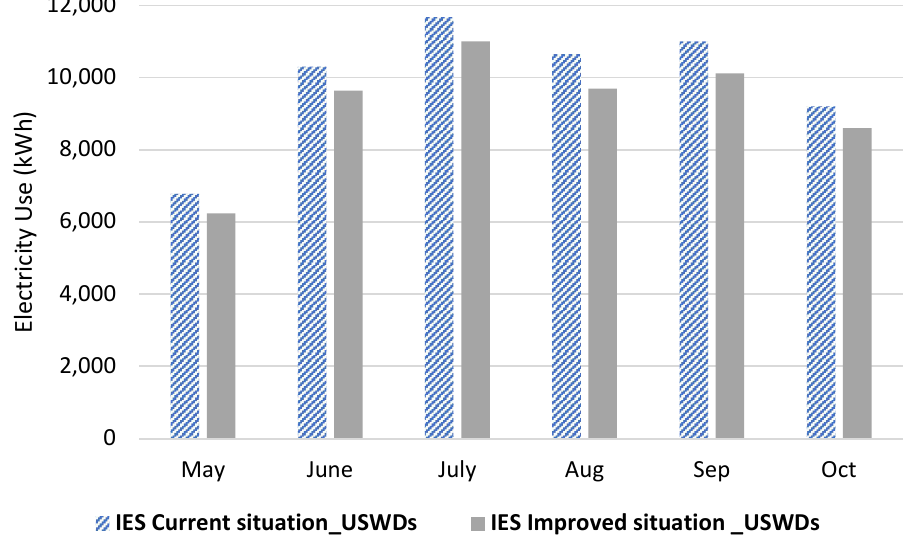
Figure 12. Comparison of the electricity consumption of the IES-VE using USWDs for the base case v. USWDs for the amended case.